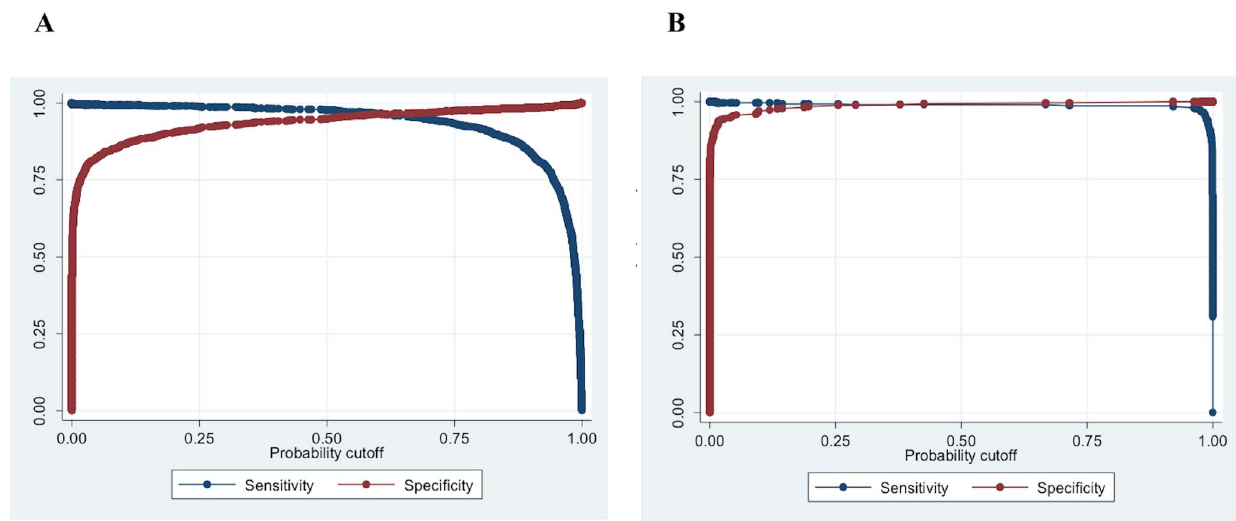
Figure 7. Sensitivity and specificity of the best model to diagnose Mycobacteriumtuberculosis from a MODS culture digital image. (A) Sensitivity and specificity for different probability cutoffs for the best object-model to classify M. tuberculosis cords; (B) Sensitivity and specificity for different probability cutoffs for the best photo-model to classify M. tuberculosis positive MODS culture images.